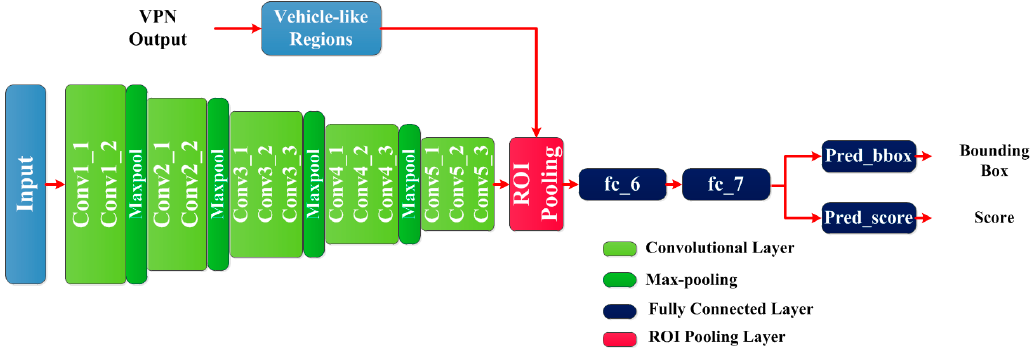
Figure 5. The architecture of VDN.